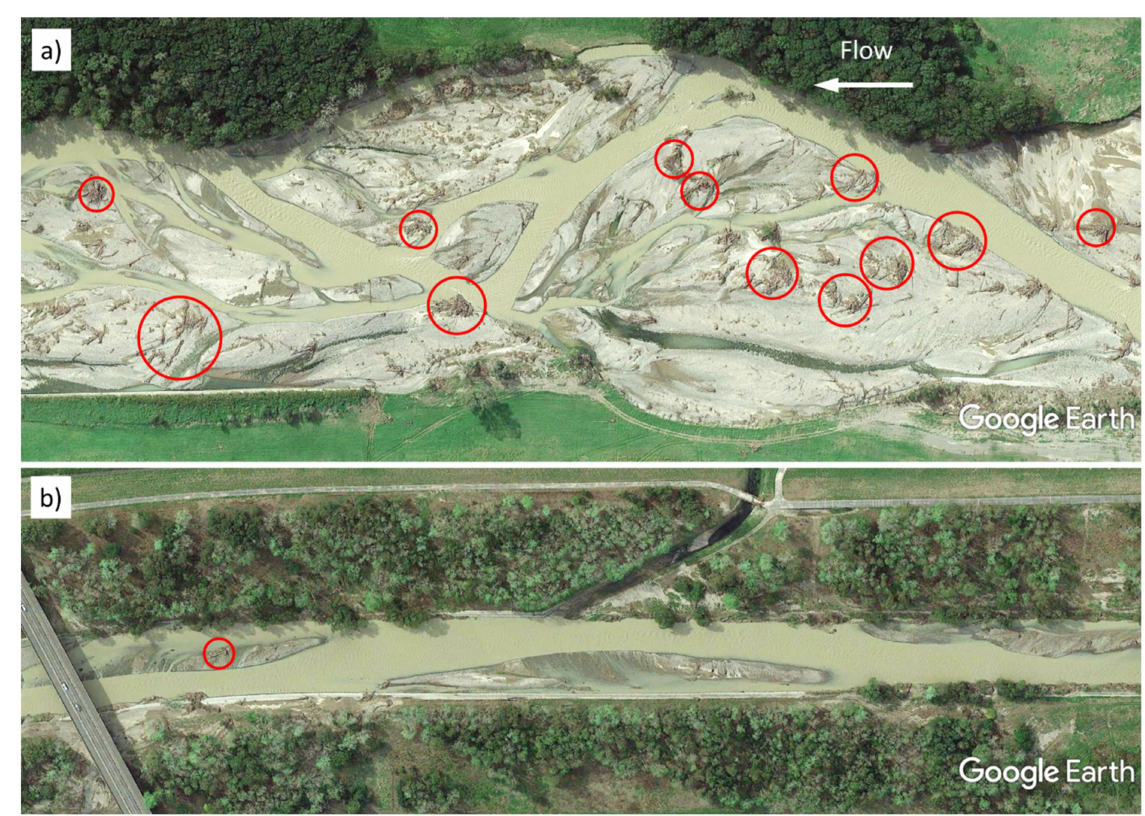
Figure 9. Spatial distribution of deposited driftwood in ( a ) braiding dominated, and ( b ) alternate-bar dominated reaches of Otofuke River, Japan after the 2016 flood event. Red circles denote wood deposition/logjam